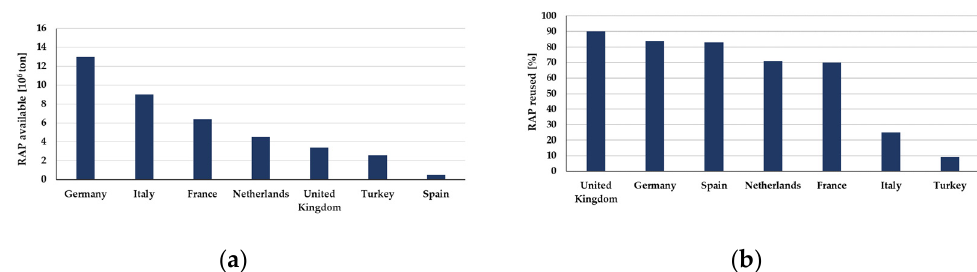
Figure 1. SITEB analysis on RAP in Europe: ( a ) RAP available in each country; ( b ) Percentage of reused RAP [50] .